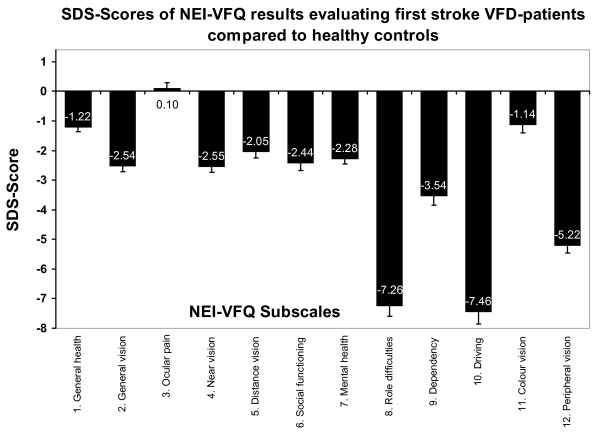
SDS-scores for NEI-VFQ of first stroke VFD-patients compared with a healthy reference group. SDS was calculated as average NEI-VFQ subscale scores in the first stroke VFD-sample minus the average value of healthy NEI-VFQ control subjects divided by the standard deviation of the control sample. The zero-line represents the baseline value of the control group sample without stroke. All NEI-VFQ SDS-scores (except ocular pain) are negative indicating that first stroke VFD-patients suffer from lower VRQoL than healthy controls.